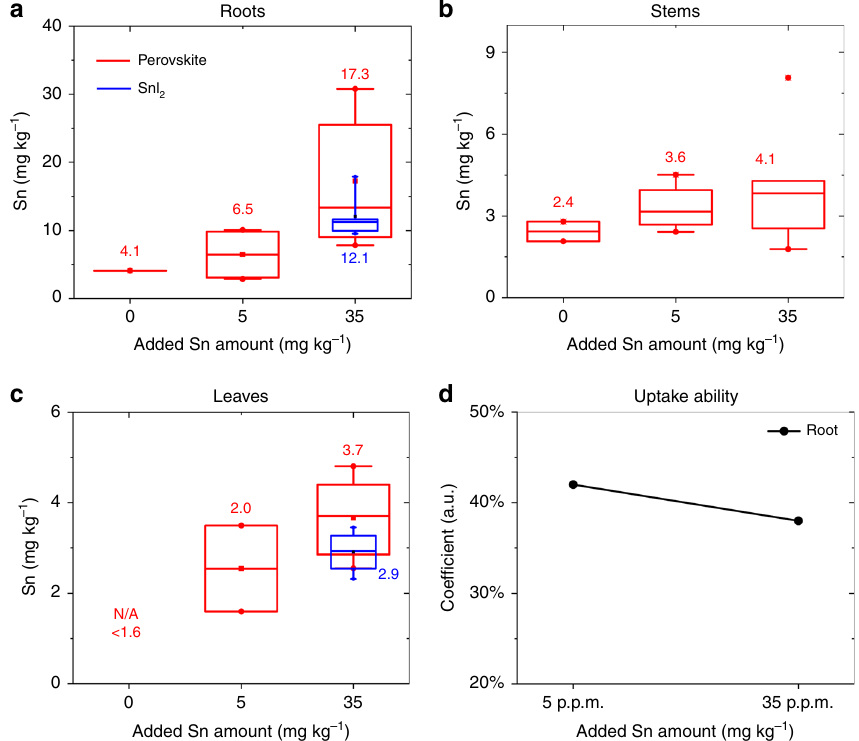
Fig. 3 Tin concentration in different parts of mint plants. a Roots, b stems, and c leaves. The tin uptake ability ( η , de fi ned in Eq. 1) is reported in d . The maximum, minimum, and mean value of each distribution are reported in a – c